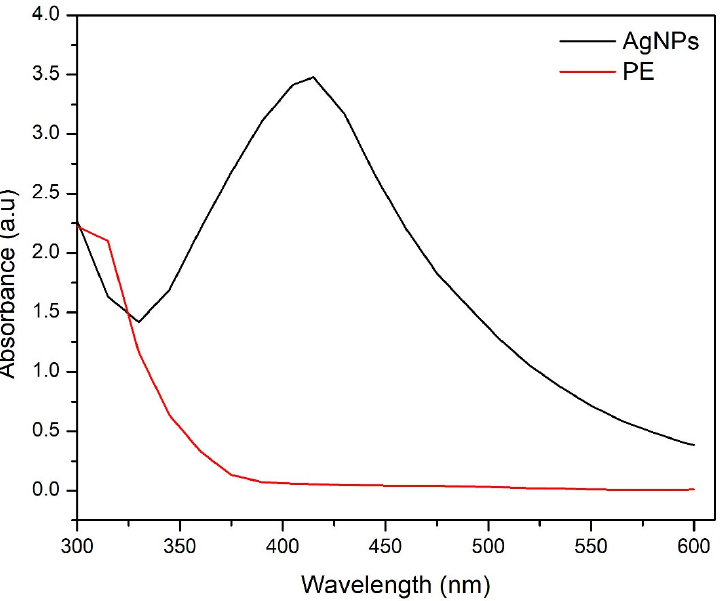
Figure 4. Optical (UV-visible) graph of washed silver nanoparticles (AgNPs) after 24 h of mixing the reactants and plant extract (PE).